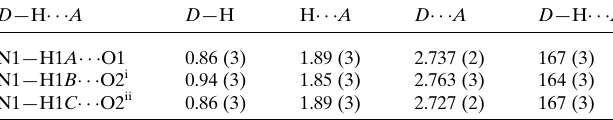
Symmetry codes: (i) (cid:3) x þ 3 2 ; y (cid:3) 1 2 ; (cid:3) z þ 1; (ii) x ; y (cid:3) 1 ; z . Table 6 Hydrogen-bond geometry (A˚ , (cid:5) ) for (VI).